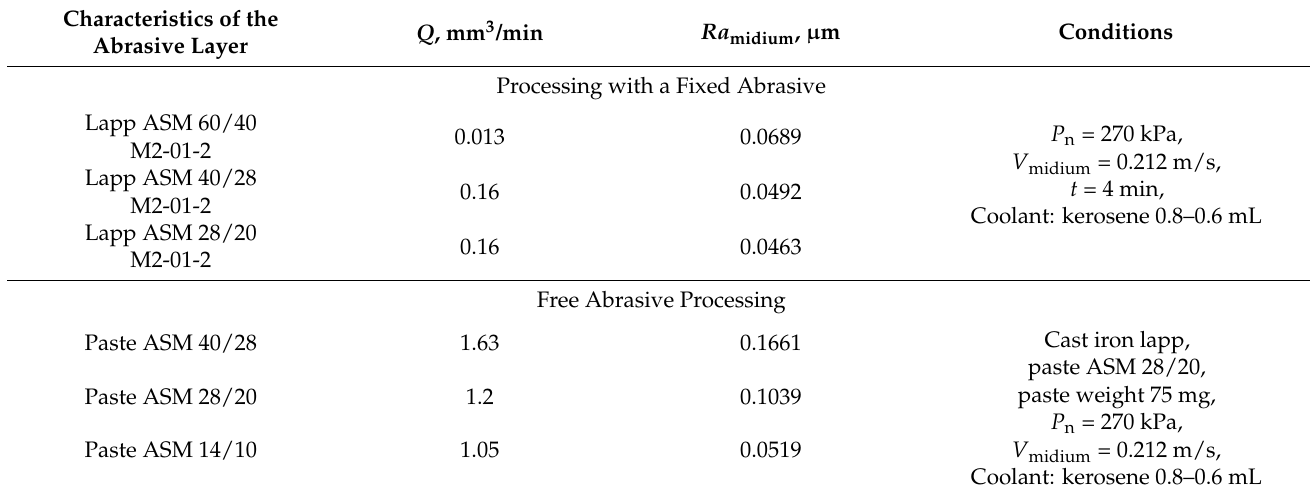
Figure 20. The effect of grain size on the roughness of ZrO 2 ceramics.